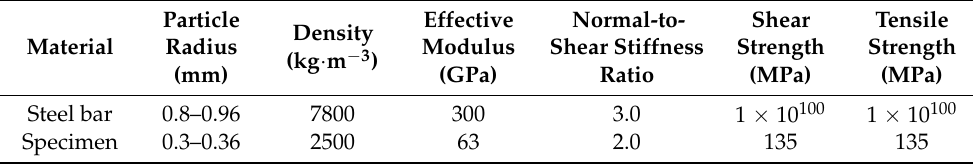
Figure 2. SHPB model. Table 1. Micro-parameters of PFC model.